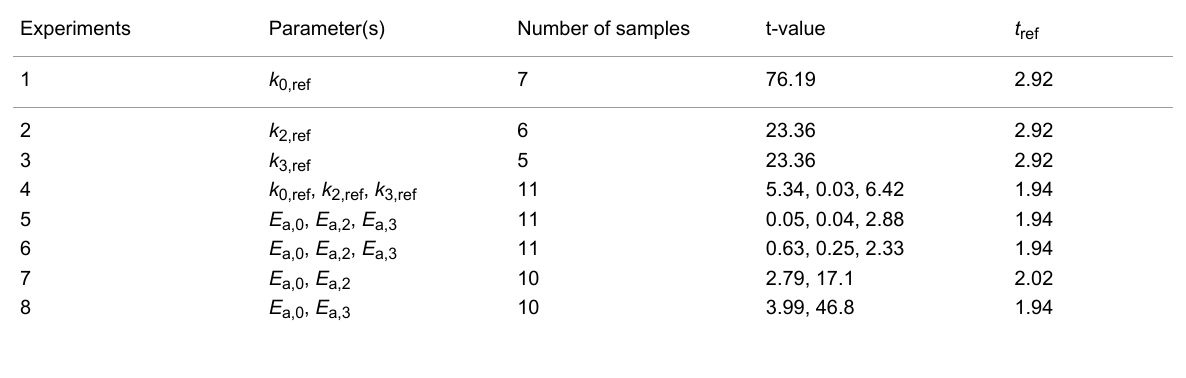
Table 2: Results of the MBDoE for kinetic parameters, showing the number of samples needed in the experiment and the statistical t-test results.